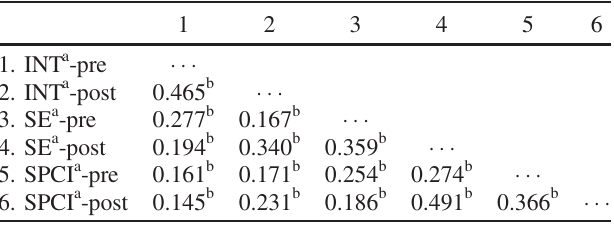
TABLE V. Correlation Matrix of the Study Variables.